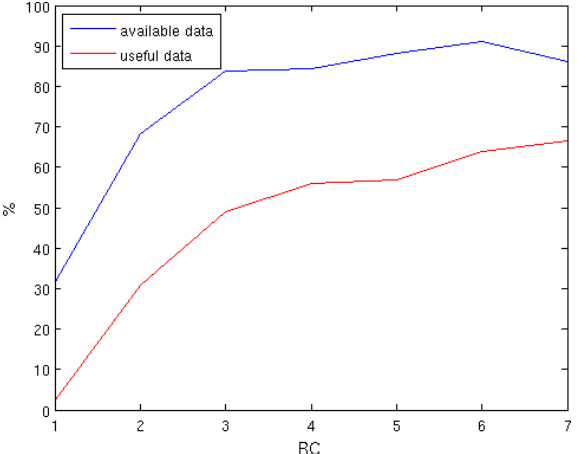
Figure 13. Percentage of HF radar data availability (blue) and useful data after applying the filter (red) for each